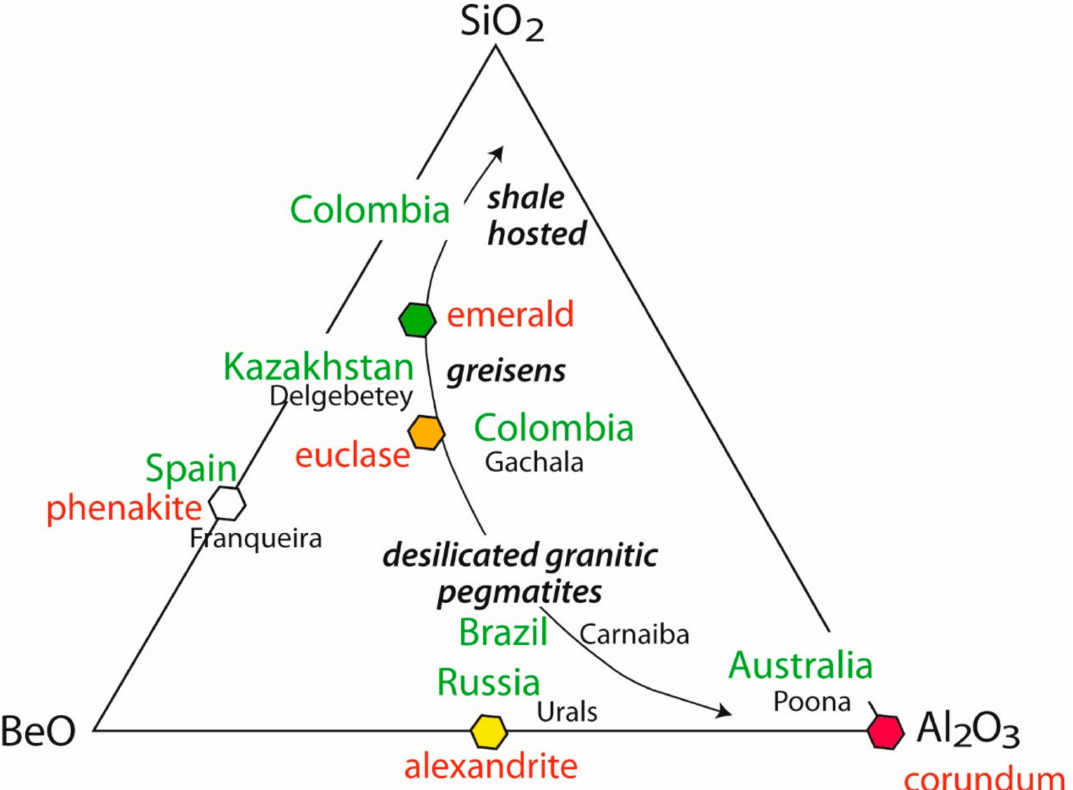
Figure 17. The ternary diagram of BeO-Al 2 O 3 -SiO 2 visualises the major types of emerald deposits as a function of their typical mineral assemblages, such as alexandrite, euclase, phenakite, and corundum (‘BASH’ system modified from [53]). Follow the discussion in the